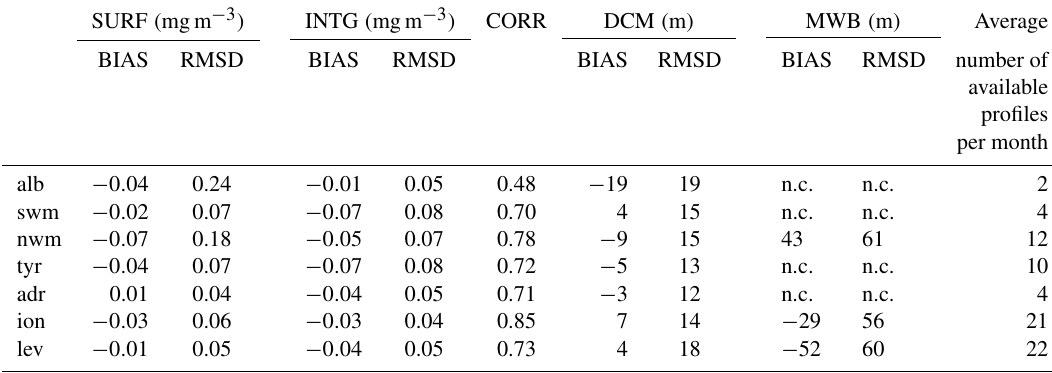
Table 3. Averages of the chlorophyll indicators based on the BGC-Argo floats and model comparison for the period January 2016– December 2017. The indicators are the BIAS and RMSD of the surface (SURF) and of the 0–200m vertically averaged (INTG) chlorophyll concentration, the correlation between model and BGC-Argo float data (CORR), the BIAS and RMSD of the depth of the deep chlorophyll maximum (DCM), and depth of the vertically mixed winter bloom (MWB). Statistics are computed for selected aggregated sub-basins; MWB statistics are not computed (n.c.) for some